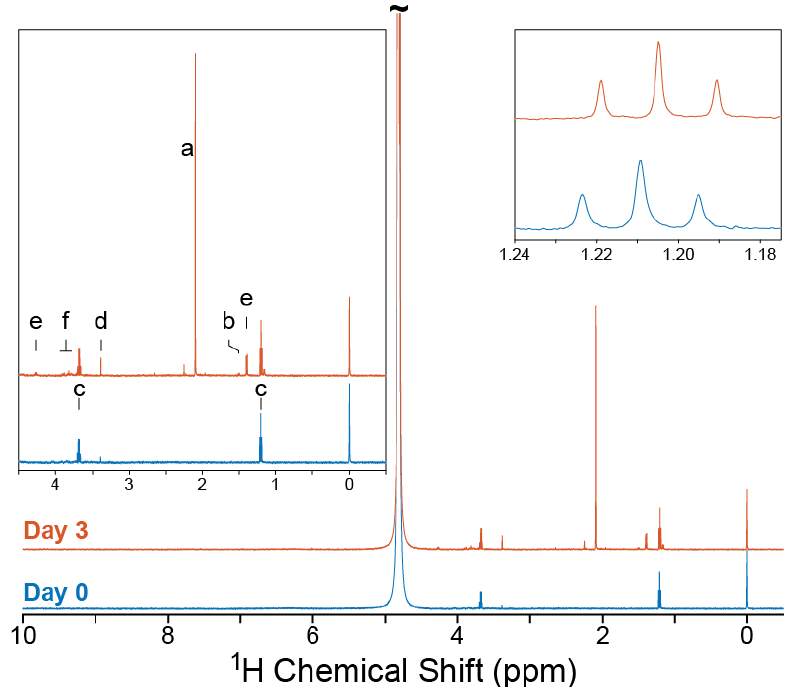
Figure 3. 1 H NMR spectra obtained with real-time NMR platform. The initial spectrum (Day 0) shows the response obtained before the addition of T. reesei to the dried orange peel waste. The final spectrum (Day 3) shows the response obtained on day 3 after the addition of fungus. Inset, left: zoom of the spectral region between − 0.5–4.5 ppm, where signals were observed to evolve during the experiment. Inset, right: zoom of the ethanol triplet signal. Abbreviations: (a)—acetate; (b)—alanine; (c)—ethanol;